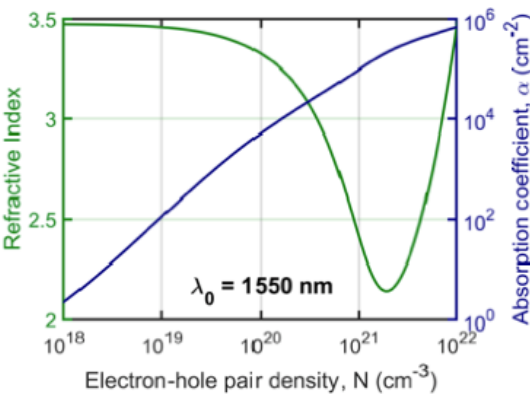
Figure 10. Simulated refractive index and absorption coefficient of an integrated waveguide for various electron-hole pair densities (after [81]).